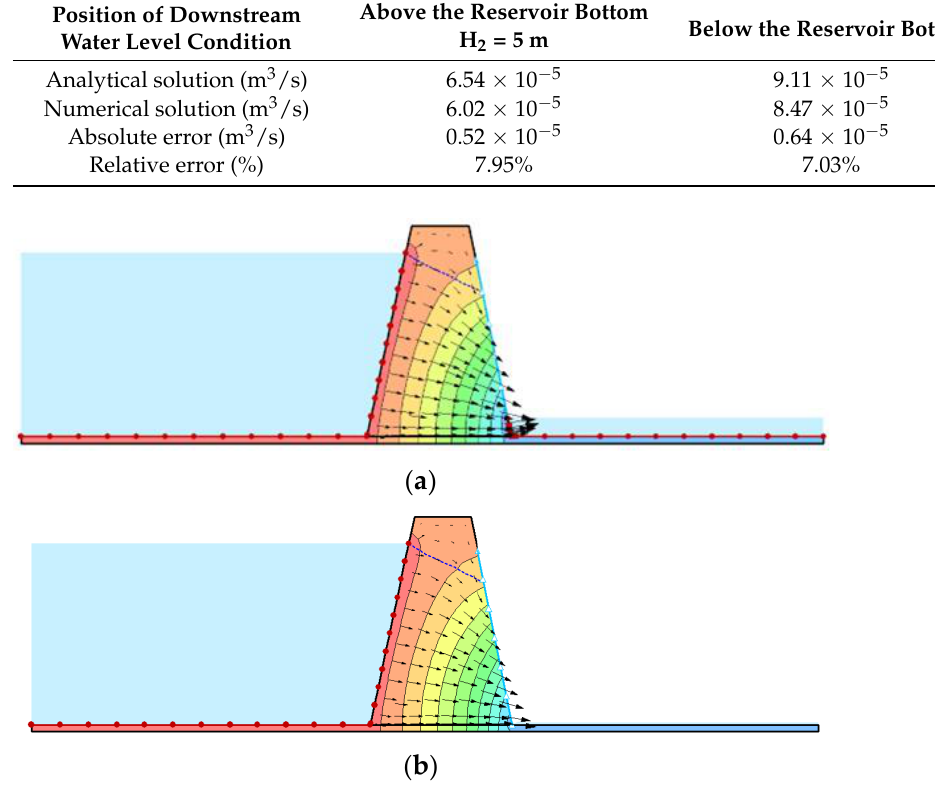
Figure 16. Streamline directions and piezometric lines of the core. ( a ) Downstream water level above the reservoir bottom. ( b ) Downstream water level below the reservoir bottom.